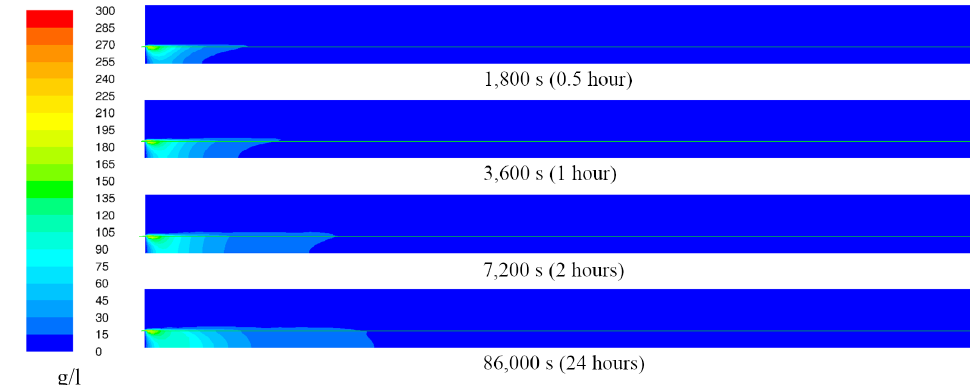
Figure 6. The impurity concentration fields in a vertical section in the middle of the computation domain. The concentration scale is from 0 to 300 g/L.